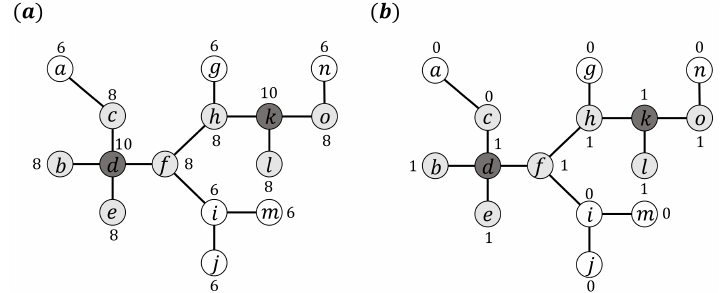
Figure 1. A snapshot of the pollutant diffusion process. The letter denotes the node in network and the digital represents the concentration label of each node. The propagation sources are S (cid:63) = { d , k } . ( a ) pollutant concentration of network diagram. ( b ) incomplete pollutant concentration of network diagram, which is similar to the contagion situation of the